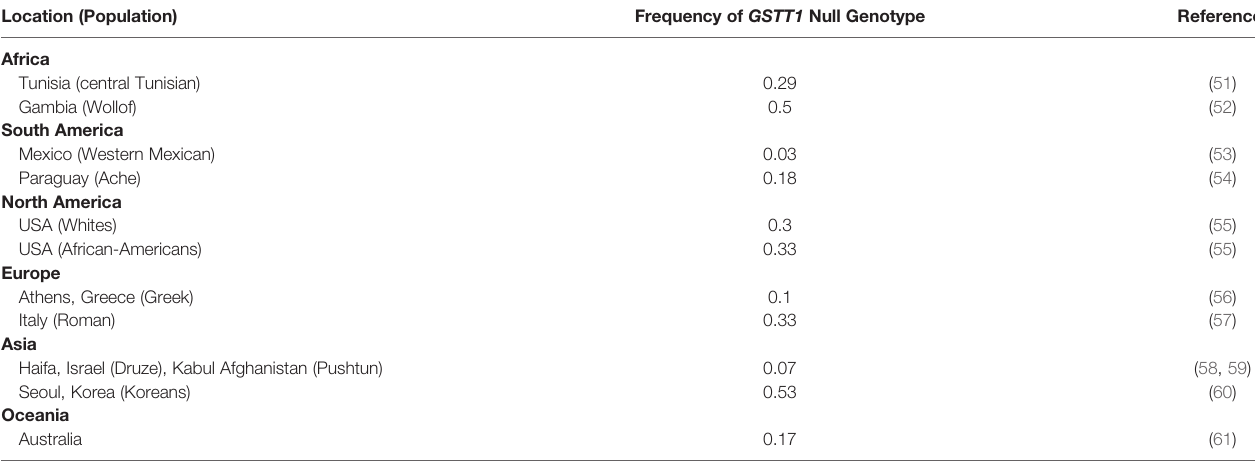
TABLE 5 | Distribution of GSTT1 -absent genotype in different regions across the globe. Location